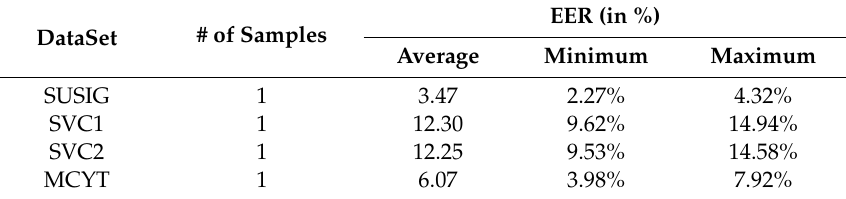
Table 5. Performances of the system with di ff erent dataset.